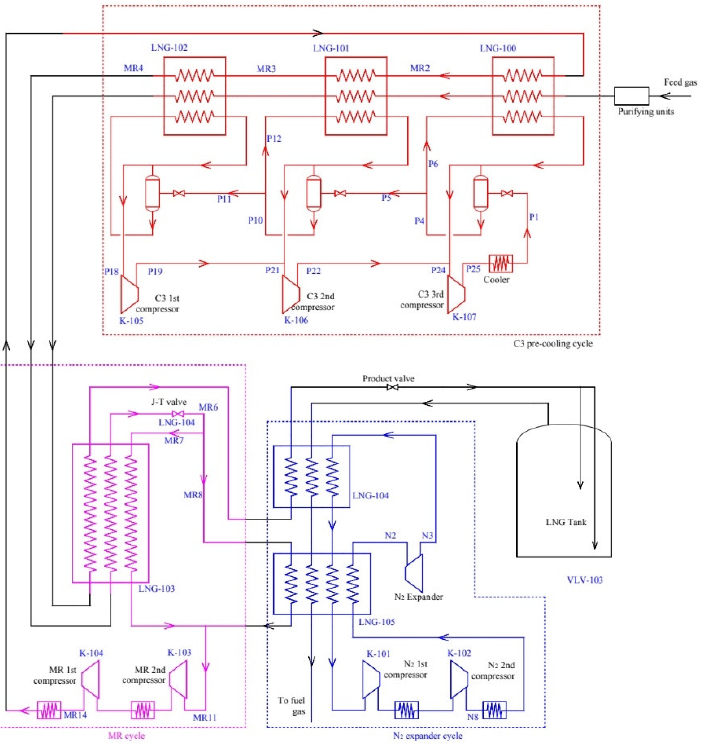
Figure 37. Process flow diagram of AP-X™ configuration [145]. Reproduced with permission from Elsevier (license number